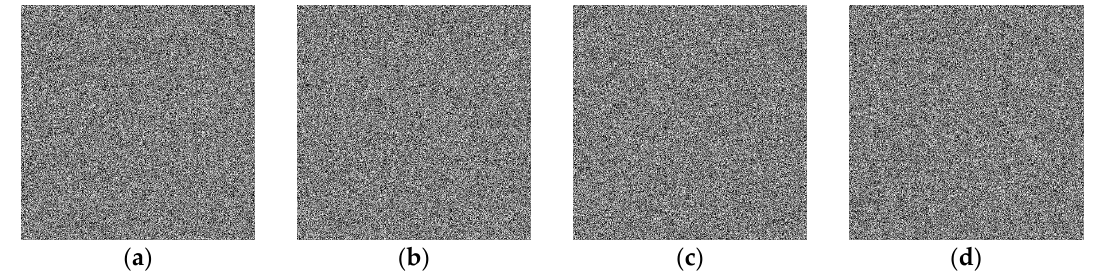
( c ) Figure 8. The decrypted results of the encrypted image with different strength noise: ( a ) k = 0.05, ( b ) k = 0.07, (c) k = 0.10. Figure 9a–c shows the decryption results of the ciphertext center being occluded by 4 × 4, 6 × 6, 8 × 8 pixels, respectively, and the corresponding PSNR values are 31.24, 25.51, 24.00 dB, respectively. ( a ) ( b ) ( c ) Figure 9. The decrypted results of the encrypted image with different pixels occlusion: ( a ) 4 × 4, ( b ) 6 × 6, ( c ) 8 × 8. 4.6. Potential Attack Analysis Usually, if the encryption can resist the chosen-plaintext attack, it can resist other common